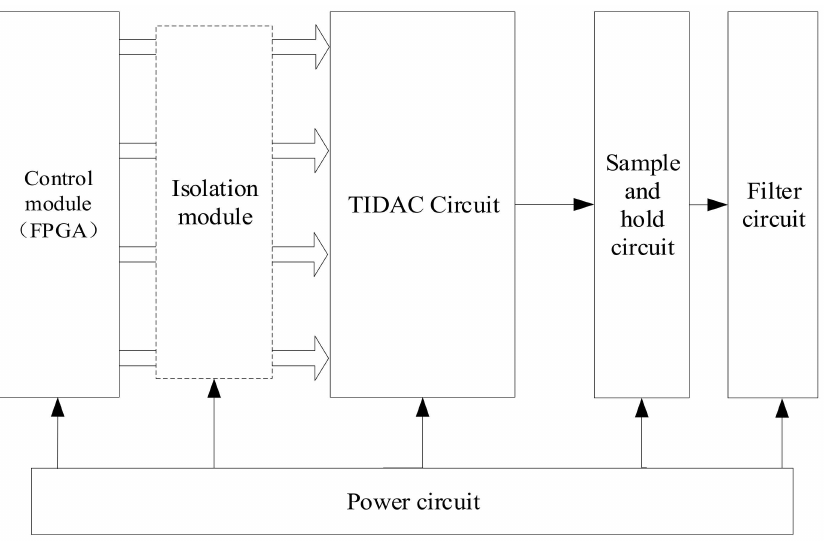
Figure 6. Block diagram of signal generation circuit based on